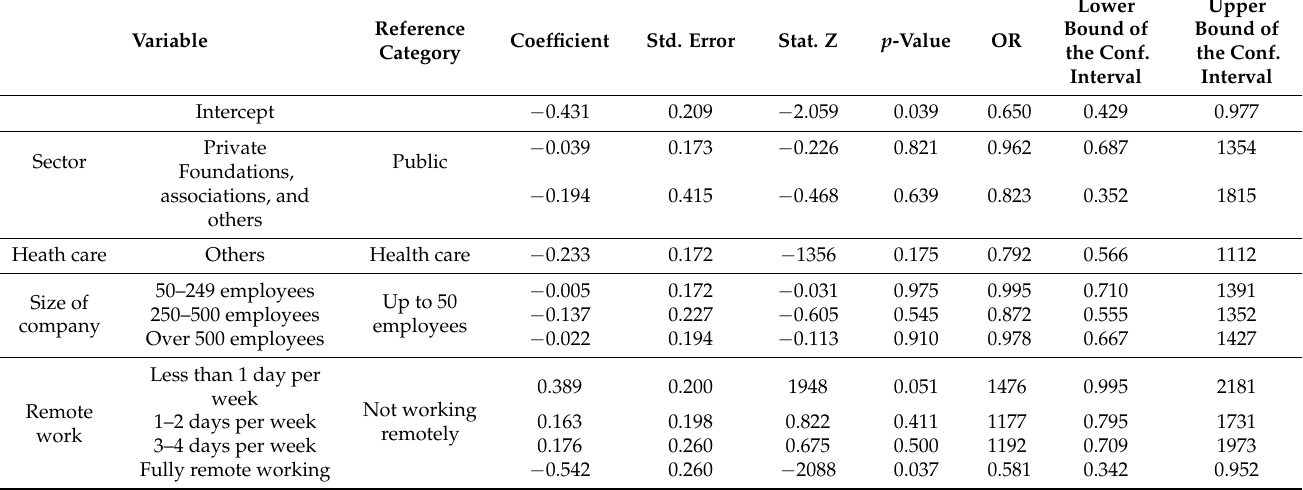
Table 6. A logistic model explaining the chance of well-being—“work–life balance”